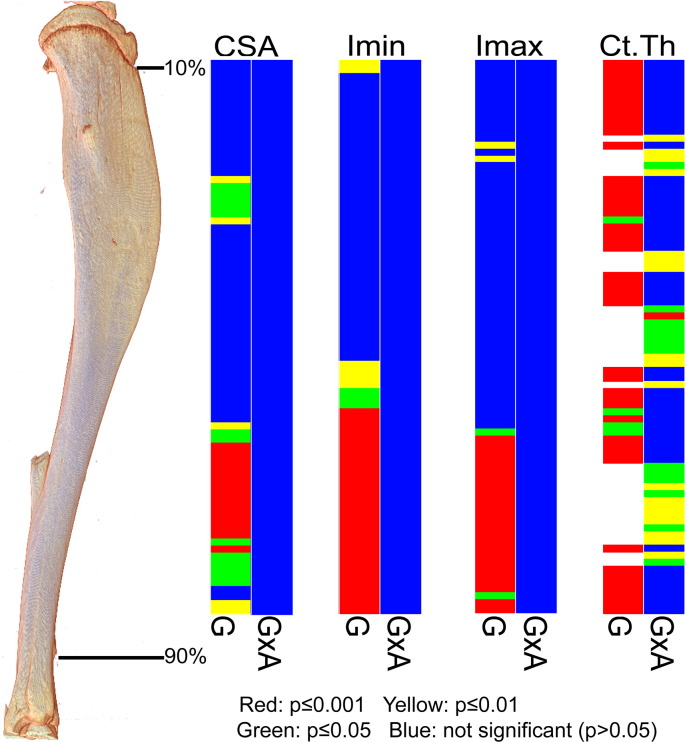
Graphical heat map representation of statistical significance of the effect of genotype (Phospho1 deficiency) (G) and its interaction with age (GxA) on CSA, Imin, Imax and Ct.Th of tibia between 10 and 90% of length. Red p ≤ 0.000–0.001, yellow p ≤ 0.001–0.01, green p ≤ 0.01–0.05 and blue p > 0.05.